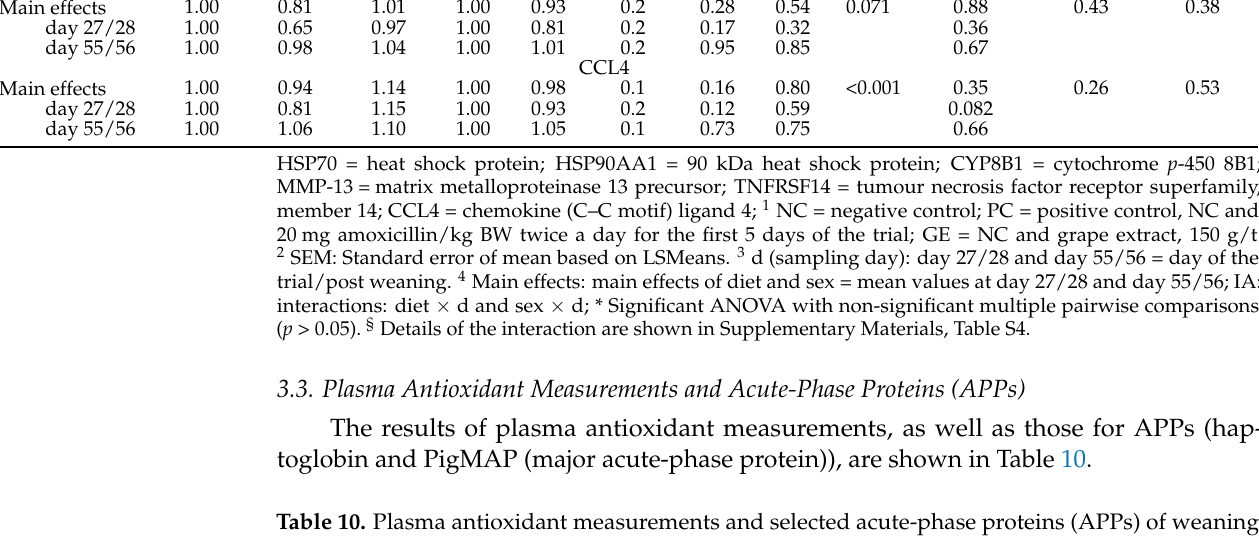
Table 10. Plasma antioxidant measurements and selected acute-phase proteins (APPs) of weaning piglets fed GE compared to NC and